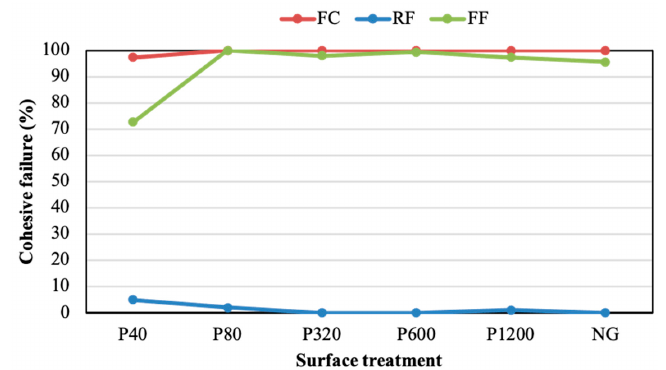
Figure 11. Cohesive failure percentage of the adhesive joints under different surface treatments with the adhesion promoter.